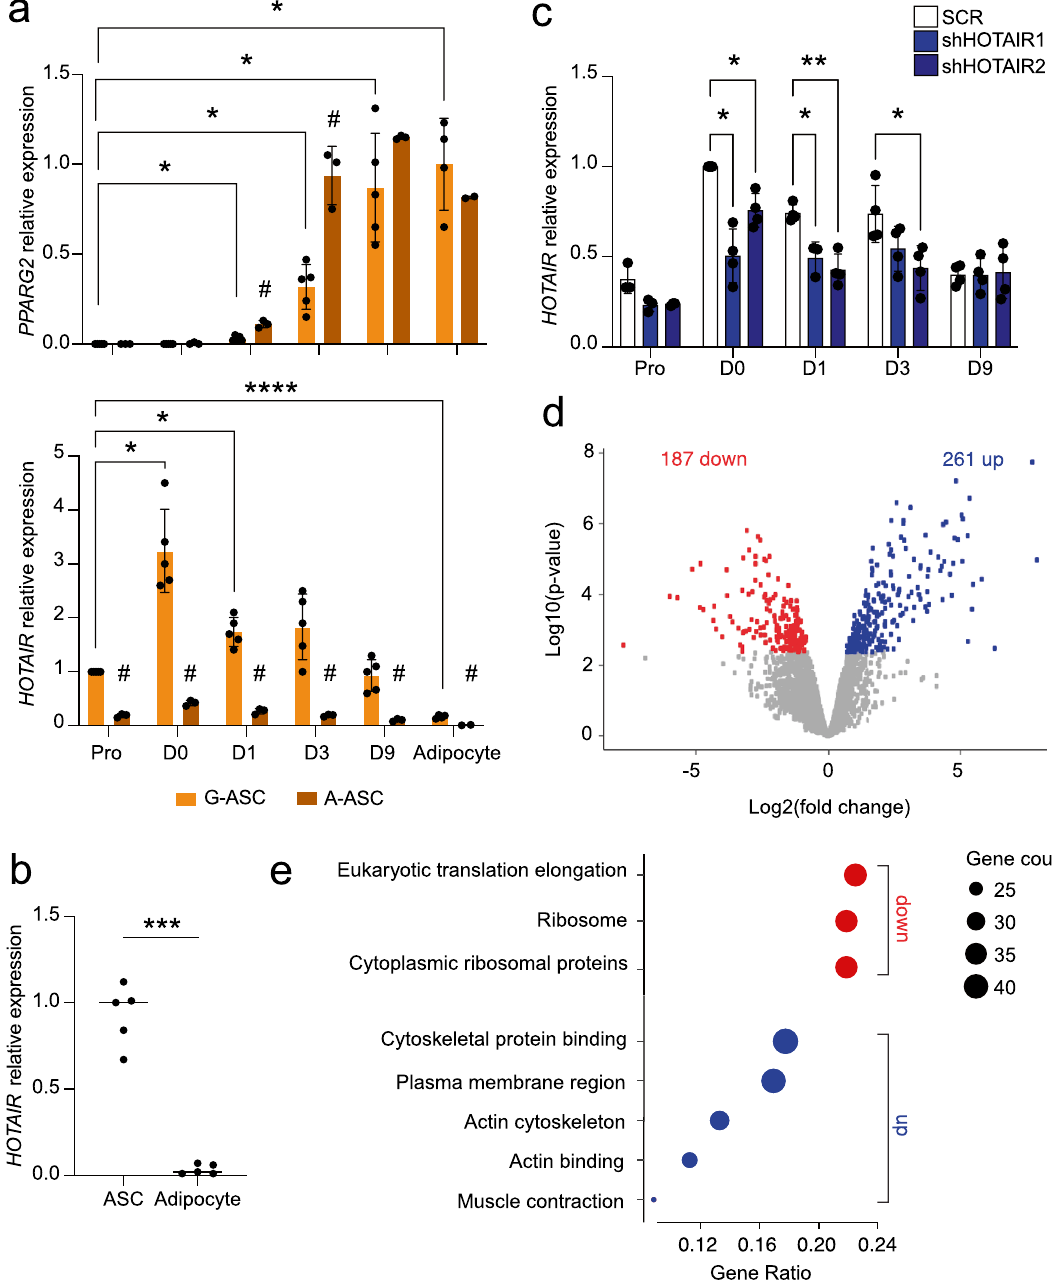
Figure 1. HOTAIR is upregulated during early adipogenesis. ( a ) Relative expression in G-ASCs and A-ASCs of PPARG2, normalized tomatched mature adipocytes, and of HOTAIR , normalized to proliferative G-ASCs (mean fold difference ± SD; * p < 0.05, ** p < 0.005, *** p < 0.001, mixed effect analysis with Šídák’s multiple comparisons test (G-ASC vs A-ASC) or Tukey’s multiple comparisons test (time-course); ASCs n ≥ 3; adipocytes n ≥ 2). ( b ) Relative HOTAIR expression in proliferative ASCs vs. mature adipocytes from the same tissue (mean fold difference ± SD; *** p < 0.001, two-tailed paired t test; n = 5 adipose tissue depots from 3 independent donors). ( c ) RT-PCR analysis of HOTAIR expression in a control (SCR) and two stable HOTAIR KD G-ASC lines (shHOTAIR1 and 2) (mean fold difference ± SD; * p < 0.05, ** p < 0.005, two-way ANOVA with Dunnett’s multiple comparisons test; n ≥ 3). ( d ) Differential expression of the top 6000 highly expressed genes between SCR and two shHOTAIR G-ASC lines (adjusted p -values < 0.05, limma, n = 3). ( e ) Overrepresentation analysis of downregulated (red) and upregulated (blue) genes from ( d ) using GO, Wikipathways, Reactome and Hallmark gene sets from MSigDb (adjusted p-values < 1.2 × 10 −6 ). The Gene Ratio is the fraction of differentially expressed genes in each gene